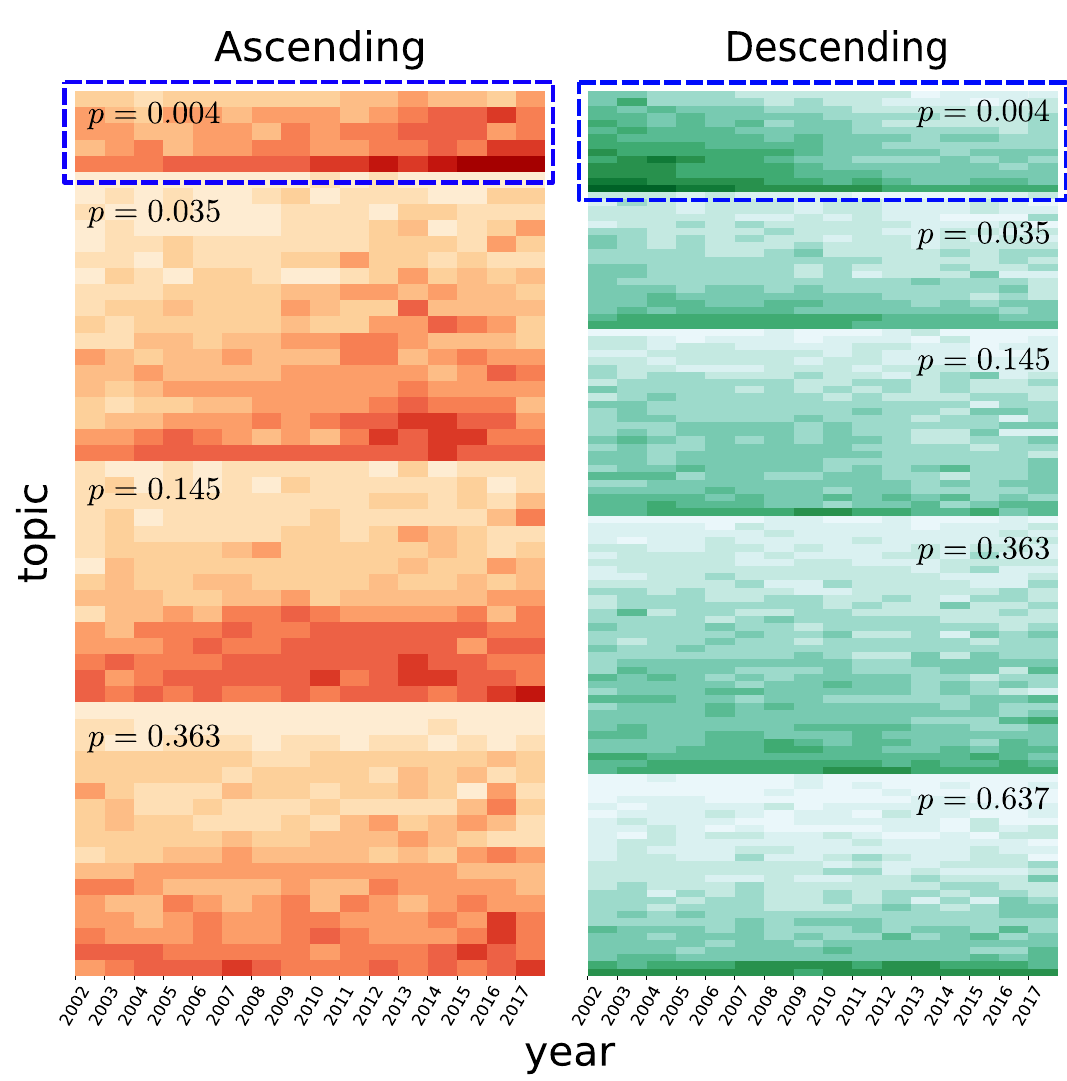
Fig 5. Temporal evolution of topic impacts of PKU around 2002-2017. The Cox-Stuart test divided the topics into ascending (left panel) and descending (right panel) classes, each of which are grouped by p -values. property (see S4 Fig): bottom degree distributions exhibit power laws while top degree distri- butions are undeterminable and vary from one to another. This property leads to the following preferential attachment model of the bipartite network G b based on a given top degree distri- sim bution p ( k ). The model starts with an empty graph. At each step, a new top node is added > and its degree k is sampled from p ( k ). Then for k links of this new top node, either connect > > to existing bottom nodes via preferential attachment based on their bottom degrees k (with ? probability λ ) or connect to a new added bottom node (with probability 1 − λ ). By tuning the value of λ one can obtain G b with the same number of top nodes n and bottom nodes n in > ? sim , which yields λ = 0.463 in our simulation. Since our focus is on users, we project G b on G b emp sim users to create the projection graph G p in which nodes represent users and two nodes are sim connected if both the users post articles on the same board. Fig 6 shows the results of PKU in November 2014 for example. Both G p and G p contain a mass of high-degree nodes, which sim emp